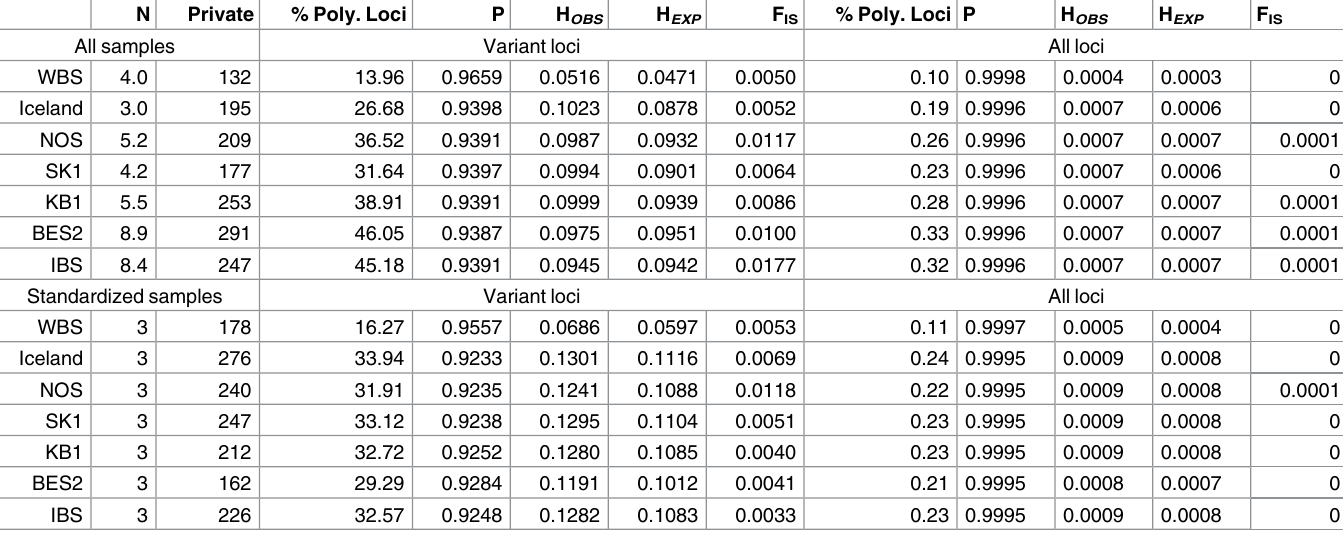
Table 1. Summary genetics statistics calculated by the Stacks populations program for 2872 variant (polymorphic) loci and all loci from all sam- ples (top). and standardized samples (three randomly selected individuals per sub-region; N = 3).